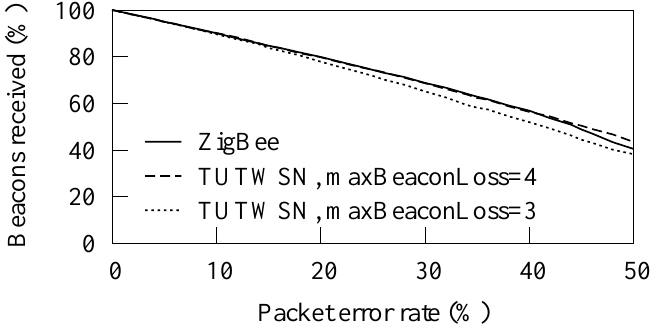
Figure 8. Beacon losses due to packet errors. TUTWSN is presented with synchronization loss after 3 and 4 consecutive beacon misses. ZigBee uses the default 4.